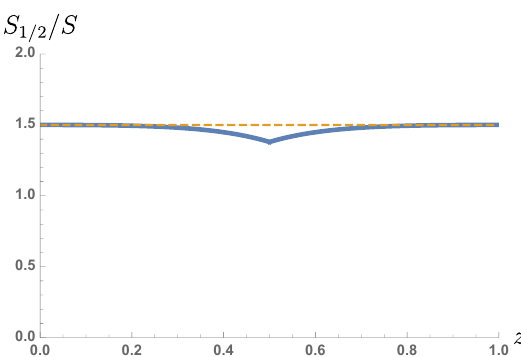
Figure 16 . Displayed is the ratio between the R(cid:19)enyi entropy at index 1/2 and the von Neumann entropy for disjoint intervals at all values of the cross-ratio. The dotted orange line represents what the ratio would be if the cosmic branes do not backreact (global conformal block only) on each other while the blue curve is the full result (graviton exchange). Intuitively, as the intervals become very far apart or very close together, the backreaction is negligible. The cusp at z = 1 = 2 corresponds to the transition from connected to disconnected cosmic branes. We use the Zamolodchikov recursion formula to numerically compute the blue